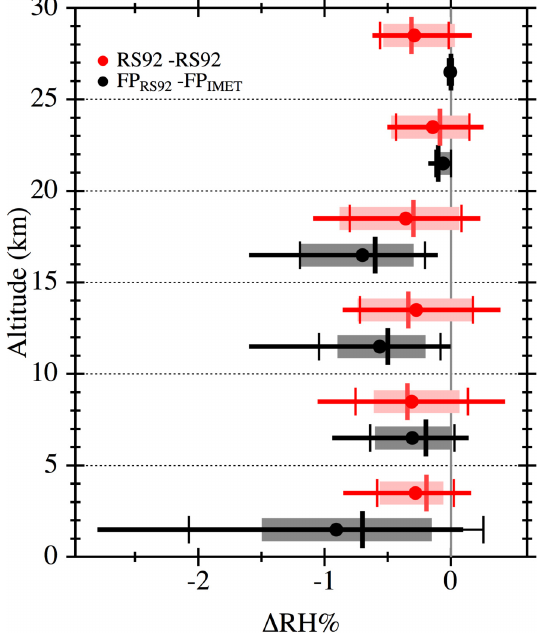
Fig. 14. Profiles of differences between RH measured di- rectly by RS92 sondes and RH calculated from frost point hy- grometer measurements using coincident RS92 temperature data (RS92-FP RS92 ). Five profiles are identified as anomalous. The mean ± standard deviation of 1 RH for the majority of difference profiles is − 0.6 ± 1.3%RH. The standard deviation range is much narrower than the RS92 manufacturer’s total RH measurement un- certainty range of ±